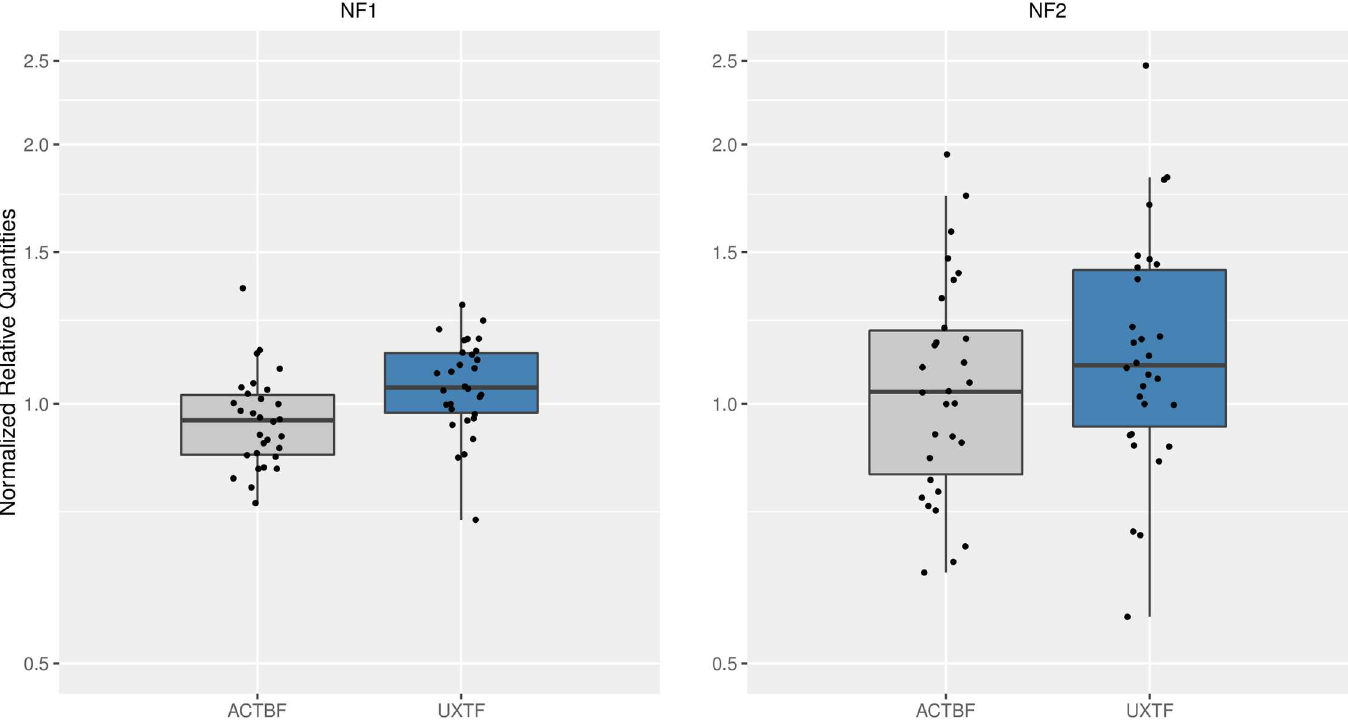
Fig 3. Evaluation of referencegenes for bovine rumen. The relative quantitiesof genes ACTBF and UXTF were normalized for each sample againstthe 2 best-scored(NF 1 ) and the 2 worst-scored references (NF 2 ). Y-axis is shown in